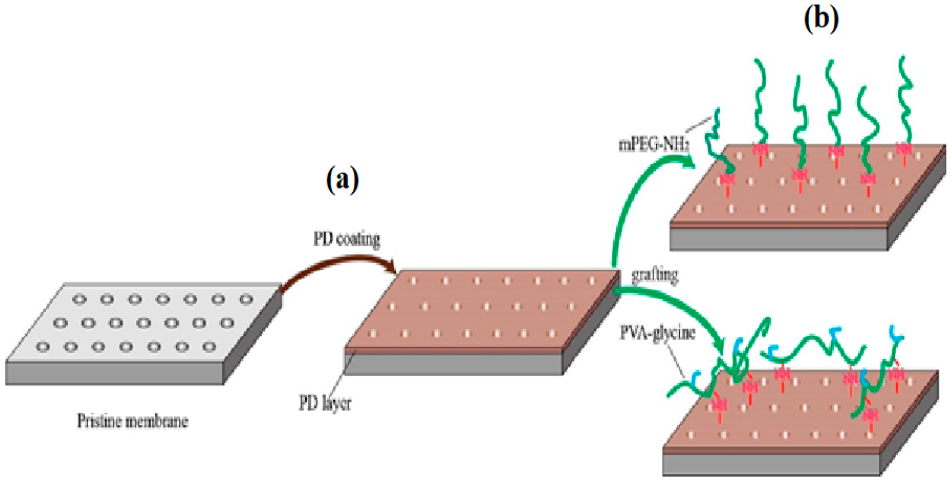
Figure 7. Schematic diagram of the surface modification technique ( a ) surface coating and ( b ) surface grafting adapted from [206].